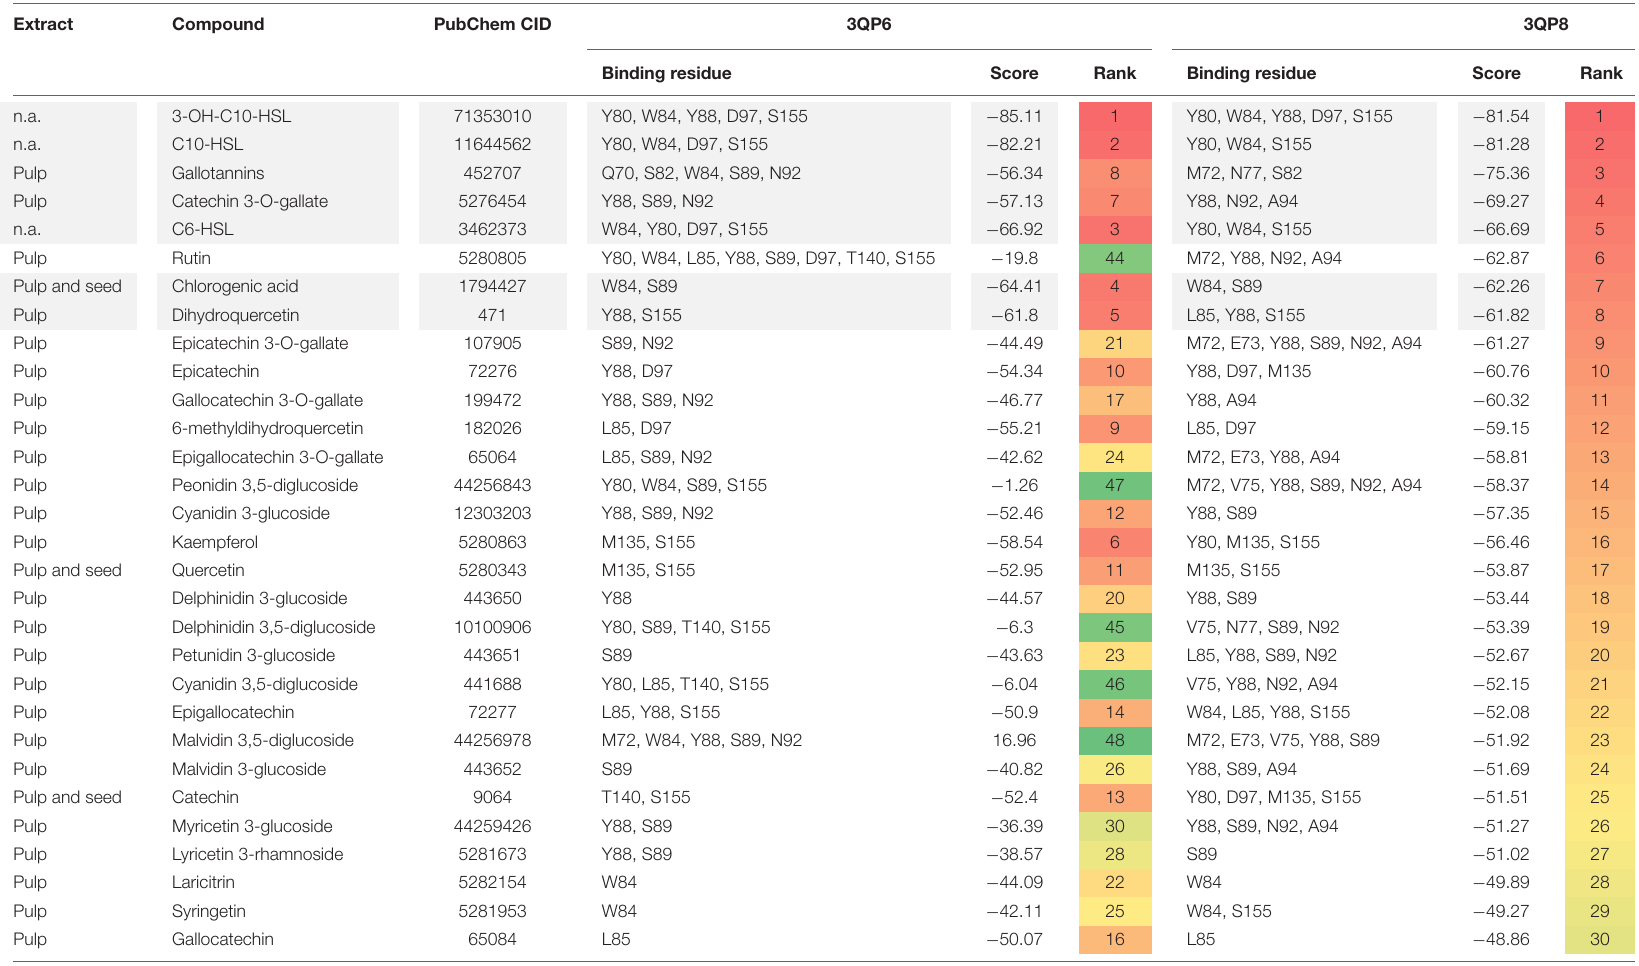
TABLE 5 | Molecular docking of CviR structures of C. violaceum ATCC 12472 with phenolic compounds found in pulp and seed extracts of S. cumini (L.) Skeels.